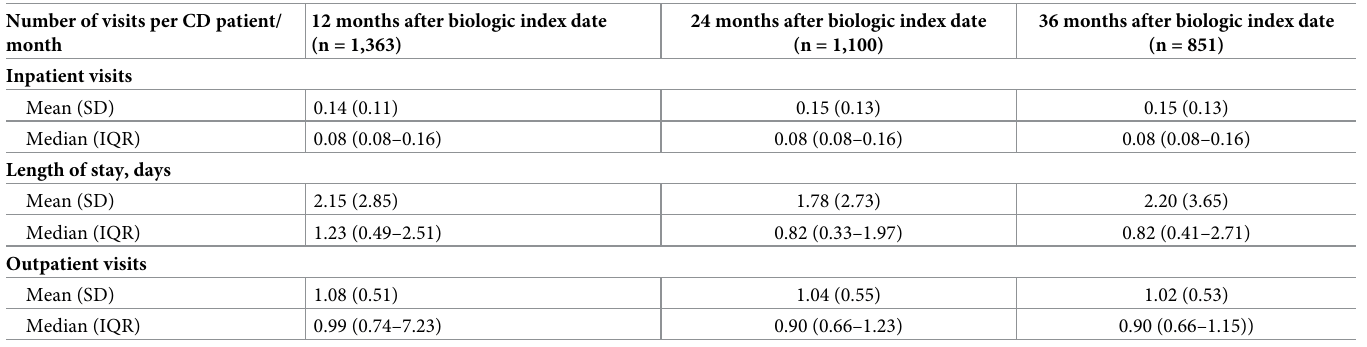
Table 3. CD-related HRU 12 months, 24 months 36 months after biologic index date. Number of visits per CD patient/